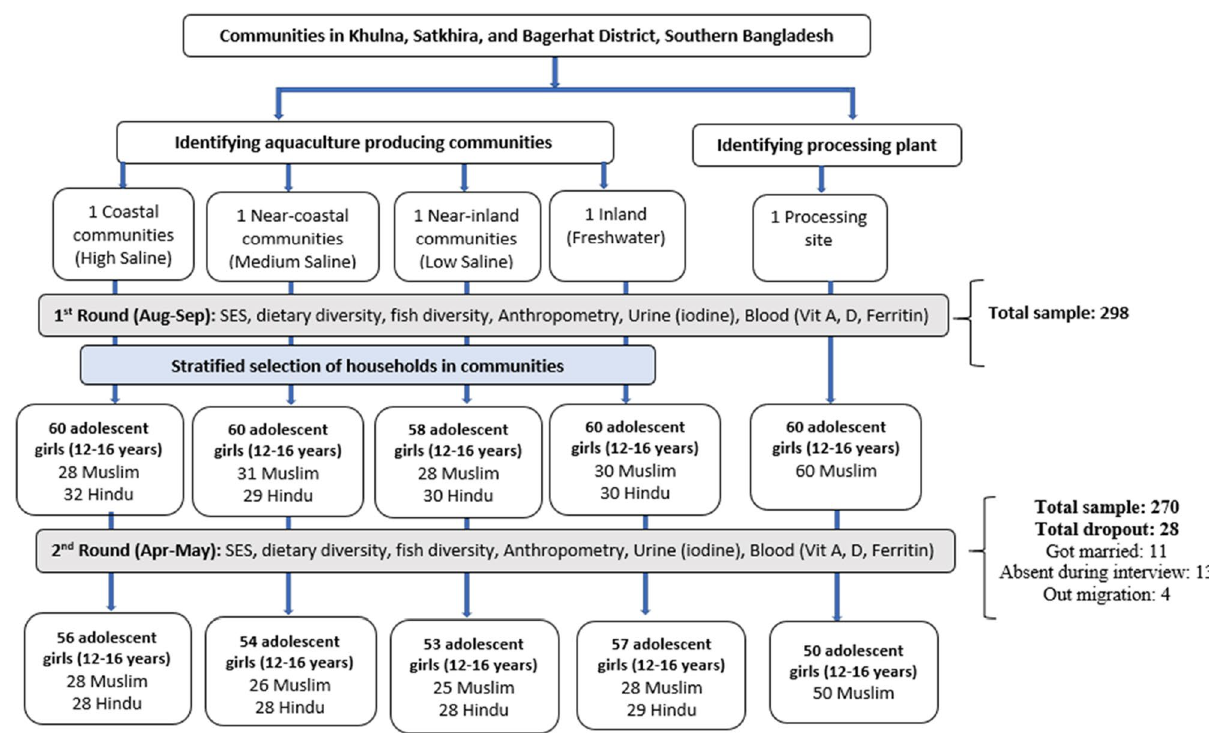
Figure 1. Schematic diagram of stratified sampling and the two seasonal survey